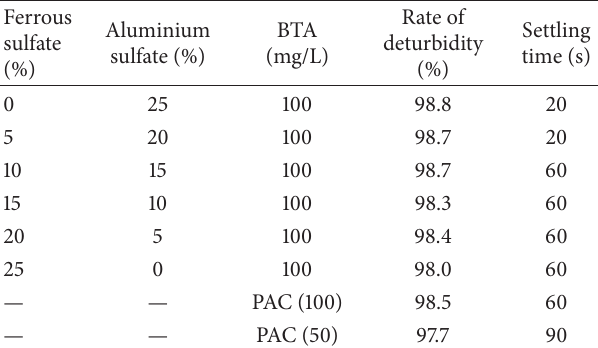
Figure 3: The influence of pH on coagulation behaviors of